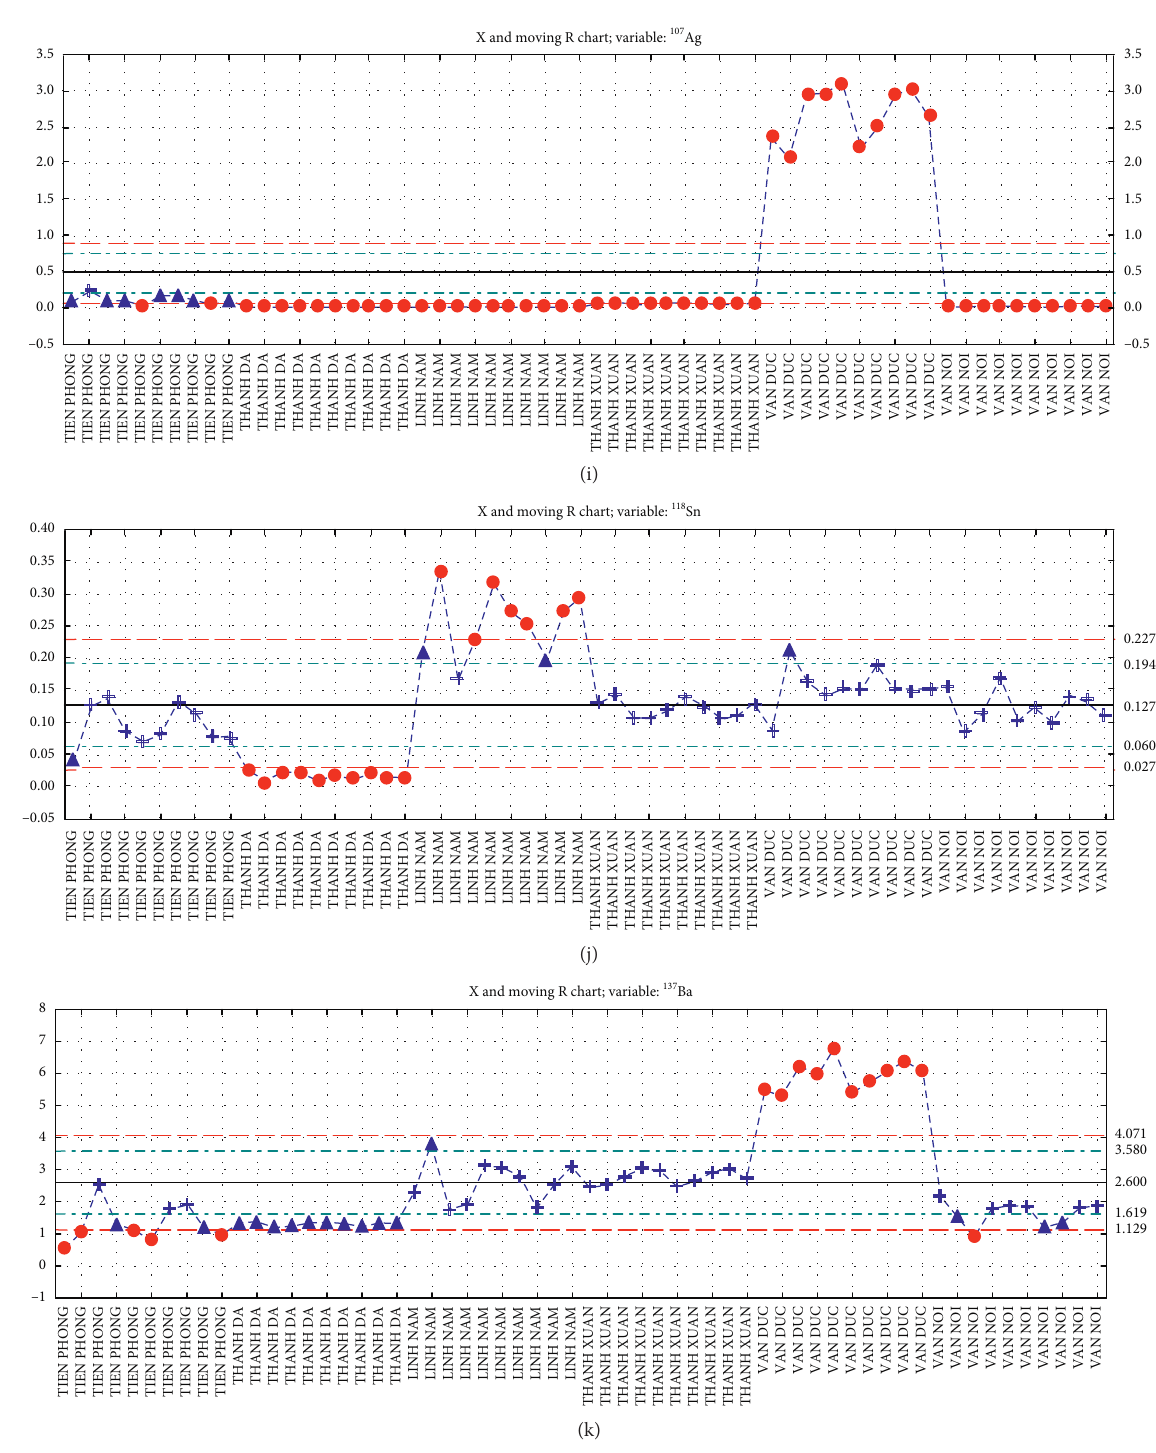
Figure 5: Moving range chart of (a) 28 Si, (b) 56 Fe, (c) 59 Co, (d) 63 Cu, (e) 69 Ga, (f) 75 As, (g) 85 Rb, (h) 93 Nb, (i) 107 Ag, (j) 118 Sn, and (k) 137 Ba. The vertical axis illustrates the content ( µ g/g, fresh weight base) of each element in the sample. The horizontal axis shows names of the